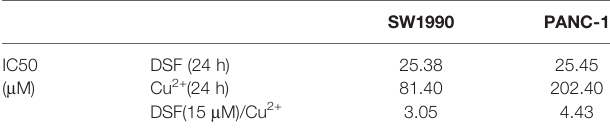
TABLE 3 | IC50 values of PANC-1, SW1990 cell lines treated with DSF in Figure 1